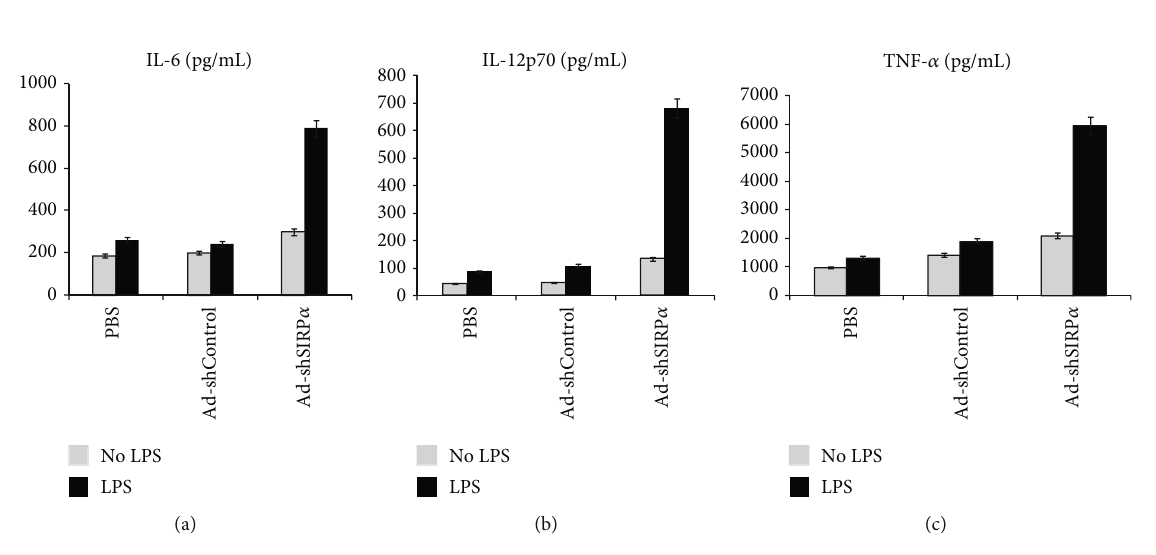
Figure 2: Cytokine secretion analysis. Cytokines of TNF- α , IL-12, and IL-6 produced by SIRP α -silenced DCs with or without LPS stimulation were quantitated by ELISA. Silencing SIRP α in DCs drastically enhanced such cytokine production in the presence or absence of LPS stimulation. Data are representative of three independent assays. p < 0 : 01 versus Ad-shControl transduced